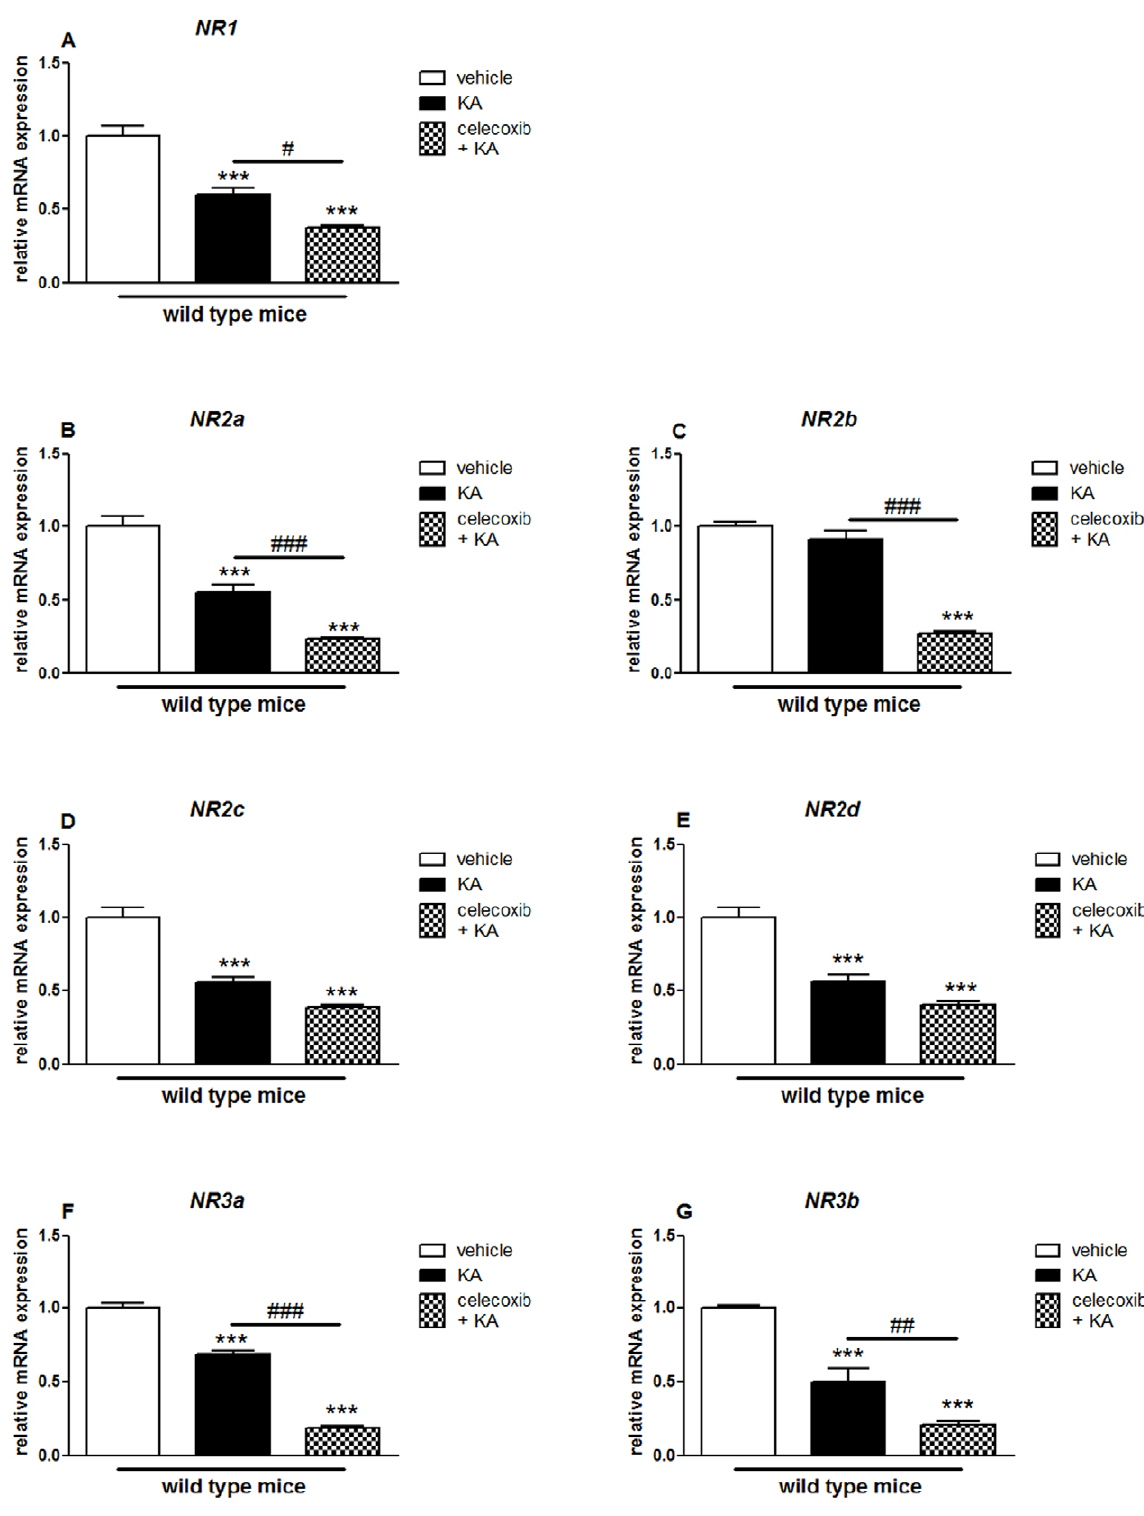
Figure 7. Effects of pretreatment with celecoxib on KA-induced mRNA expression of NMDA receptor subunits in the hippocampus of wild type mice. Quantitative real time-PCR analysis of NR1 (A), NR2a (B), NR2b (C), NR2c (D), NR2d (E) NR3a (F), NR3b (G) in WT mice, after two weeks treatment with celecoxib, followed by an i.p. injection of KA or vehicle 24 hours later. Data are means 6 SEM ( n =9). Statistical analysis was performed using a one-way ANOVA and Bonferroni’s post-hoc test. *P , 0.05, **P , 0.01, *** P , 0.001 compared to vehicle-injected WT mice; # P , 0.05, ## P , 0.01, ### P , 0.001 compared to KA-injected WT mice.